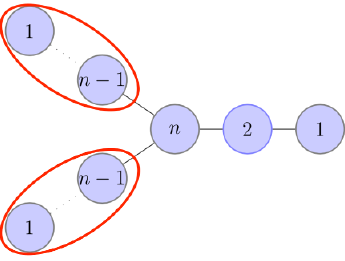
Figure 11 . The 3D mirror of the S 1 reduction of the R 0 ;n SCFT. Nodes labeled by \ N " repre- sent U( N ) gauge nodes and lines between nodes denote bifundamental hypermultiplets (an overall decoupled U(1) is removed). The R 0 ;n index has a TQFT expression with three independent wave functions corresponding to the three quiver tails in the above diagram of the 3D mirror. The two quiver tails circled in red generate monopoles which are responsible for the SU( n ) 2 (cid:26) SU(2 n ) (cid:2) SU(2) (cid:13)avor symmetry of the theory (the SU(2) (cid:26) SU(2 n ) (cid:2) SU(2) factor comes from the third tail, and the balanced central node is responsible for the U(1) (cid:2) SU( n ) 2 ! SU(2 n ) (cid:26) SU(2 n ) (cid:2) SU(2)